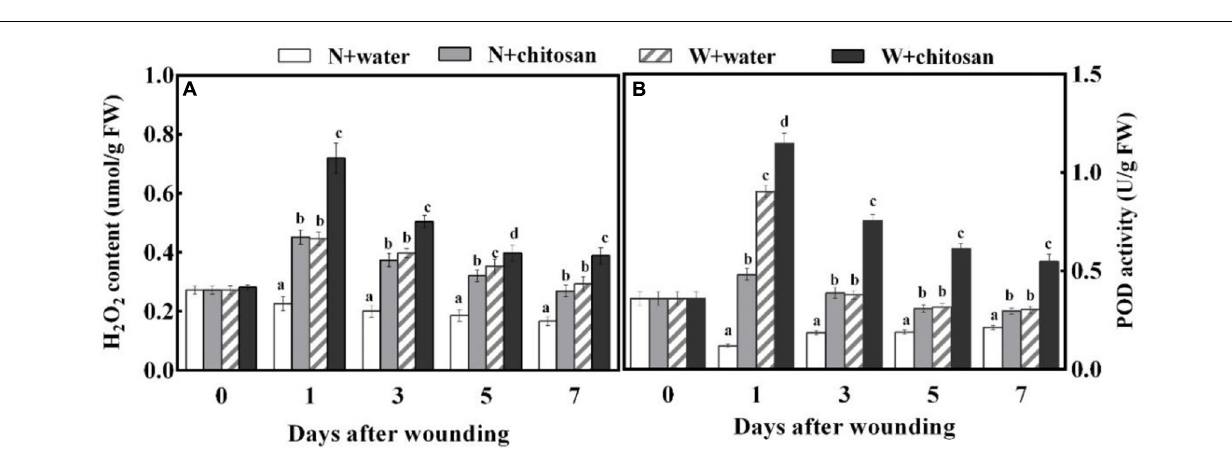
FIGURE 2 | Effect of chitosan treatment on H 2 O 2 content (A) and POD activity (B) . Non-wounded and treated with sterile water (N + water), non-wounded and treated with chitosan (N + chitosan), wounded and treated with sterile water (W + water), and wounded and treated with chitosan (W + chitosan). Vertical bars indicate standard error of means. Alphabets indicate significant differences ( p <